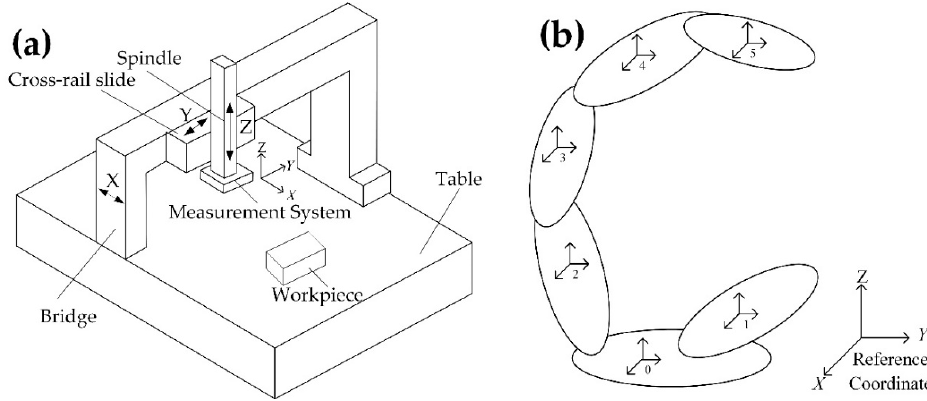
Figure 2. ( a ) Schematic diagram of the bridge CMM; ( b ) Topology structure of 3-axis MTs.